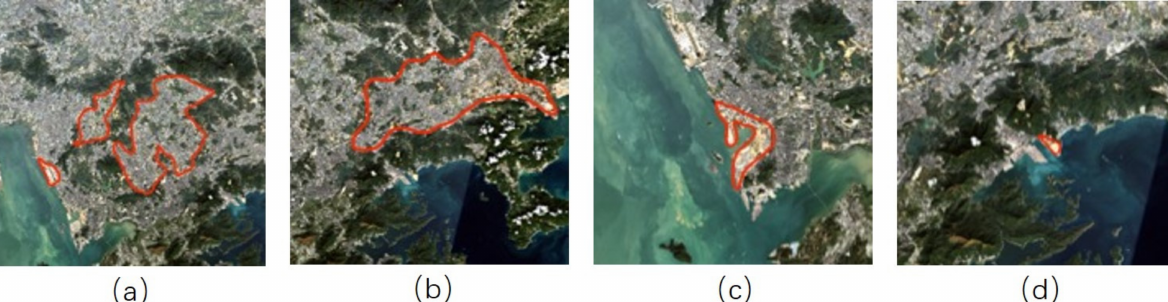
Figure 9. The increase in impervious surface areas of Shenzhen: ( a ) the central, eastern, and western part of the Baoan District; ( b ) the expansion of the Longgang District; ( c ) the expansion of the southeastern part of the Nanshan District; ( d ) the southeastern part of the Yantian District.